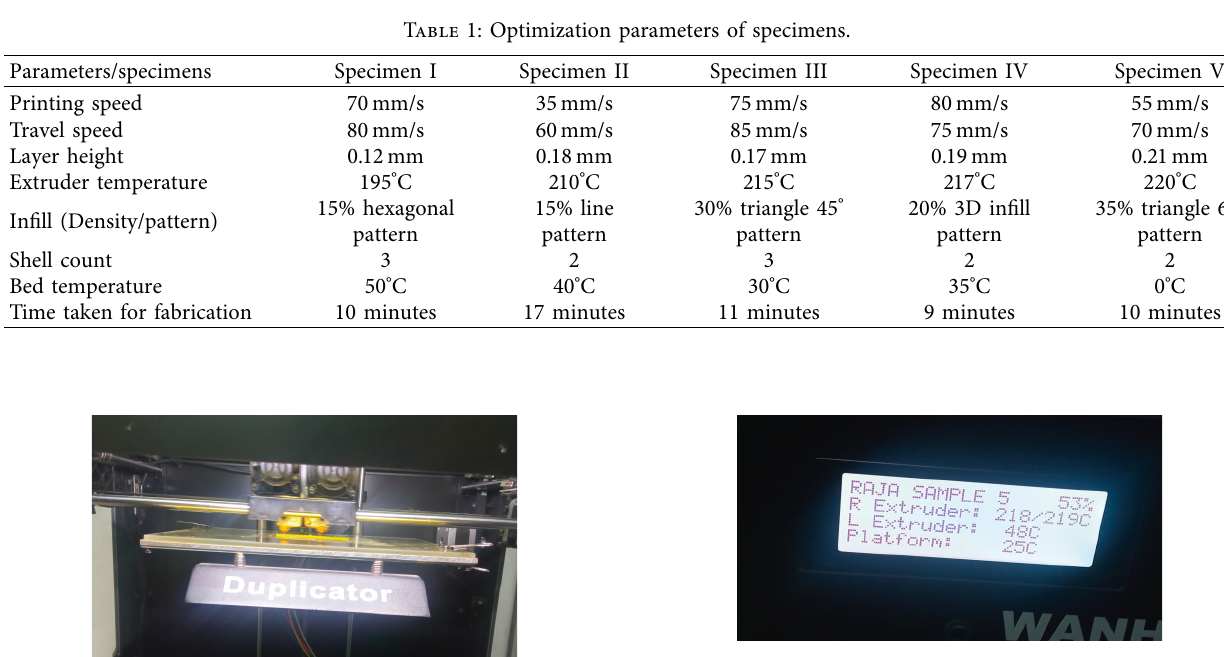
Figure 3: Fabrication temperature of the final